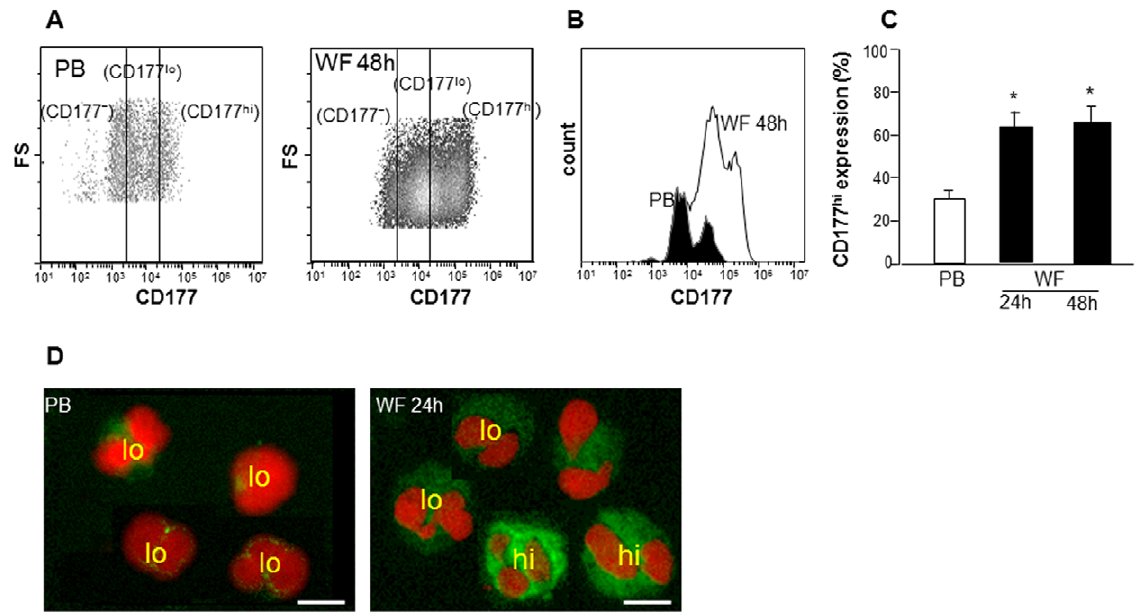
Figure 5. Increased CD177 expression in PMN derived from WF. Cells from WF and PB were immunostained with CD177 followed by flow cytometry or cytospin analysis. Representative A , scatter plot and B , histogram and C , quantification from flow cytometry analysis showing cells with low (lo) or high (hi) expression of CD177. D , Representative images of cytospun cells derived from WF or PB. The cells were immunostained with CD177 (green) and DAPI (nucleus, red). Scale bar=10 m m.